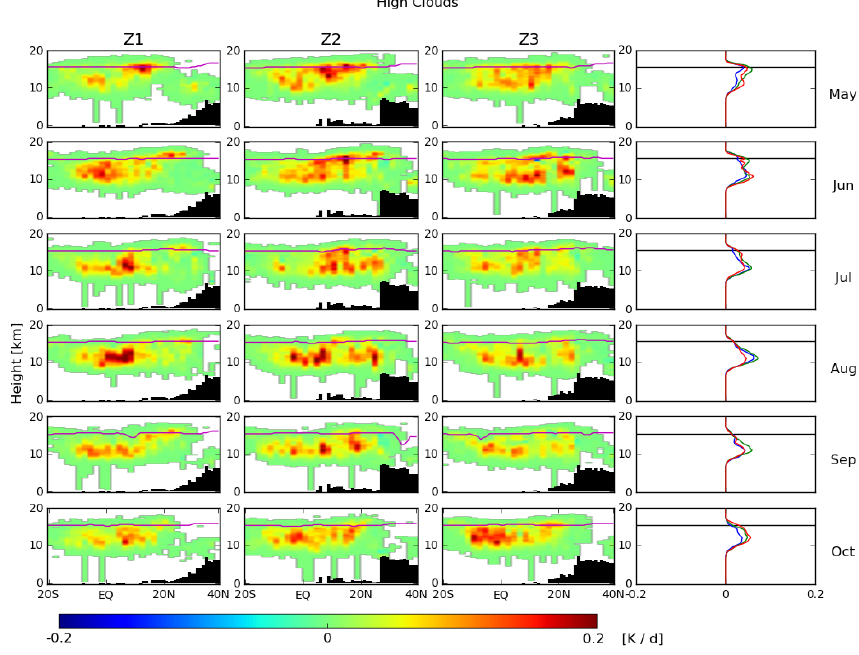
Figure 10. The monthly evolution of CRH due to high